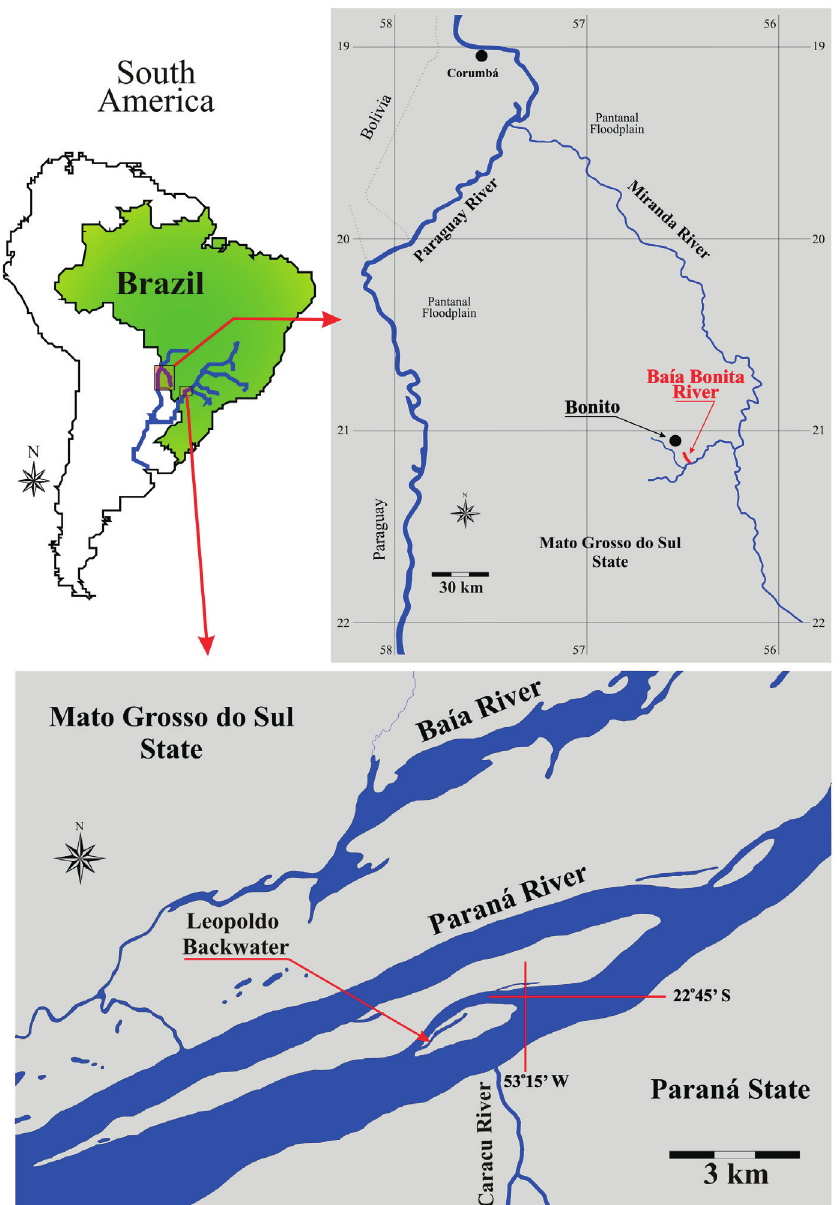
Figure 1 - Sample sites of Moenkhausia : upper Paraná River floodplain; Baía Bonita, affluent of the Miranda River, Paraguay River basin,